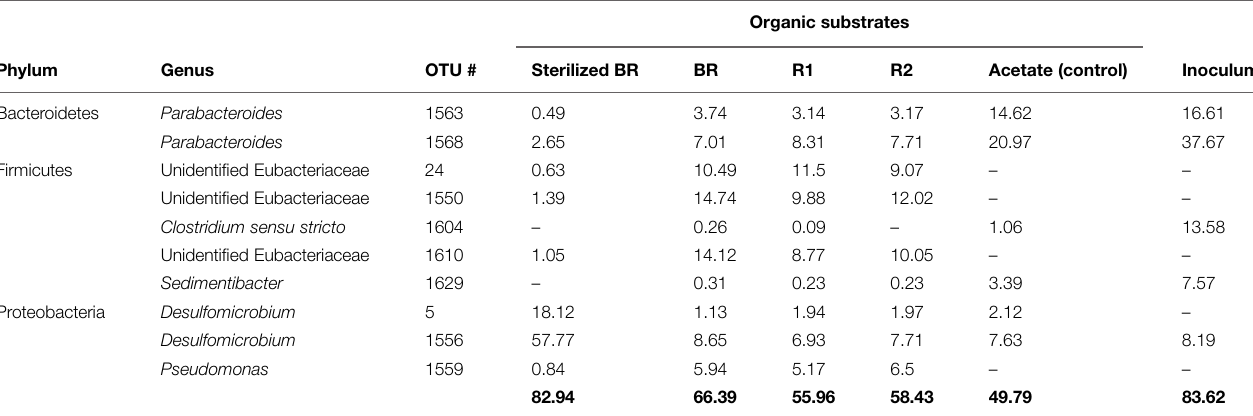
TABLE 3 | Proportion of the 10 most abundant and best-shared OTUs from the microcosms prepared with the immature shale-derived